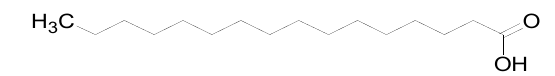
Figure 16. Palmitic acid, a base fatty acid from which other fatty acids are formed.